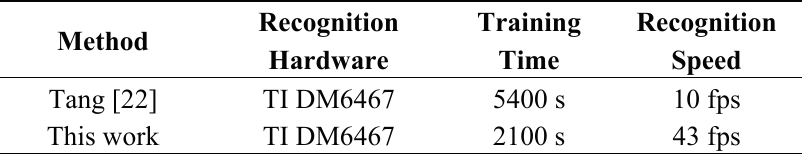
Figure 7. Testing in real conditions to obtain performance averages, and make a comparison with the work by Tang [22]. Table 10. Comparison in real